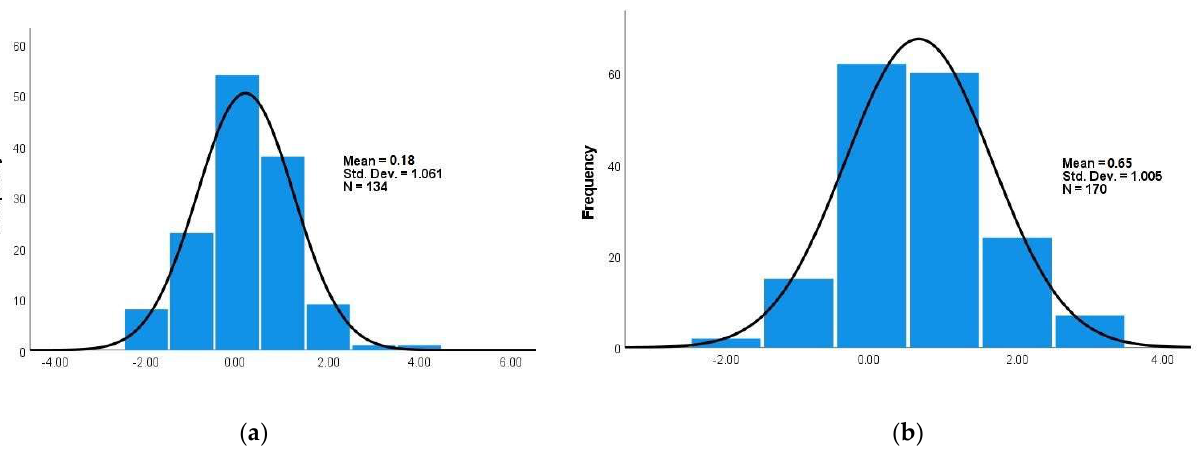
Figure 3. Impact of the course on the statement “I understand the principles of sustainable develop- ment”. ( a ) University A; ( b ) University B. ment”. ( a ) University A; ( b ) University